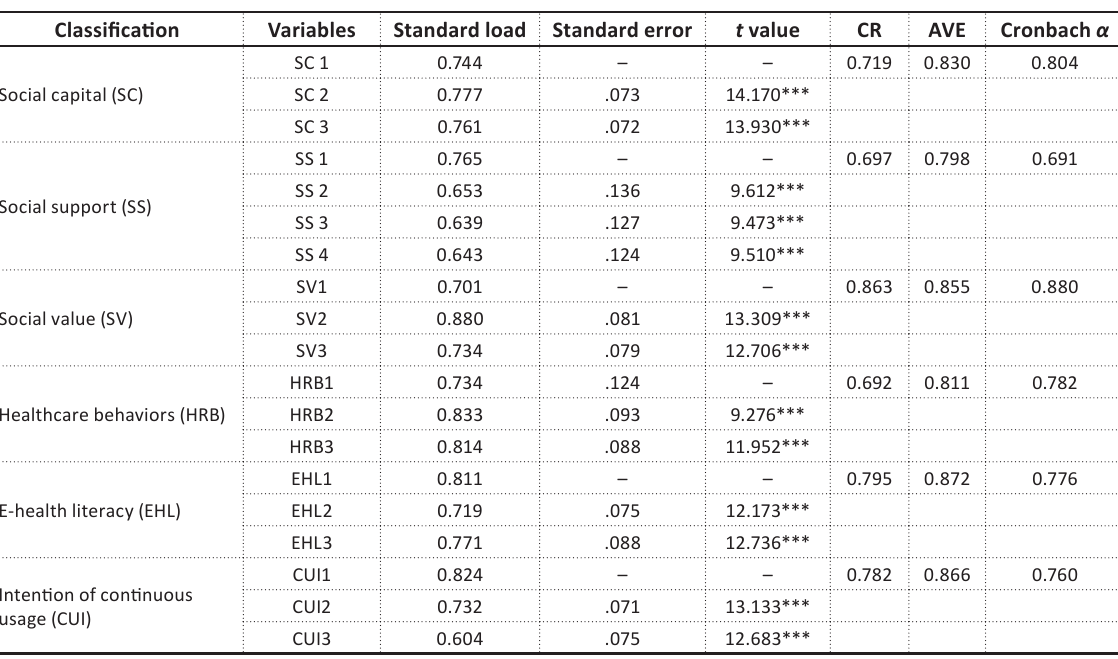
Table 2. Reliability and convergent validity test